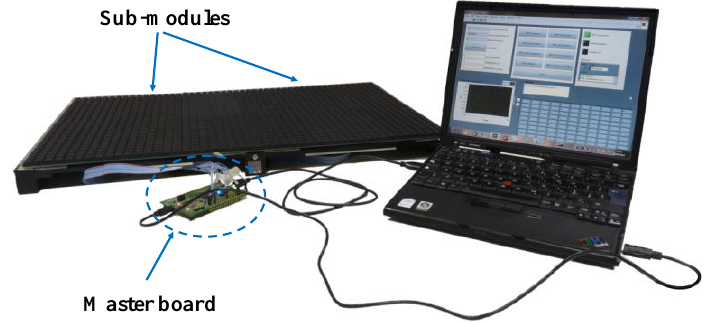
Figure 6. Sensorized mat housed onto a rigid plastic frame. The device is composed of: a master board, two sub-modules each endowed with its slave board (housed under the sensing area, within the plastic frame) and a laptop computer with a Labview interface for data